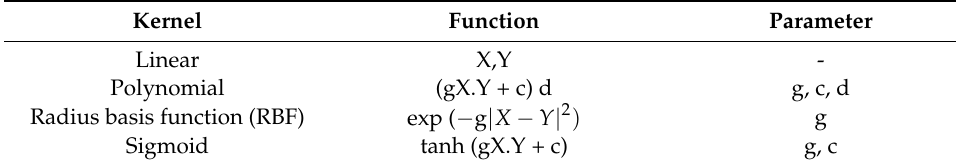
Table 2. Types of kernel used in this